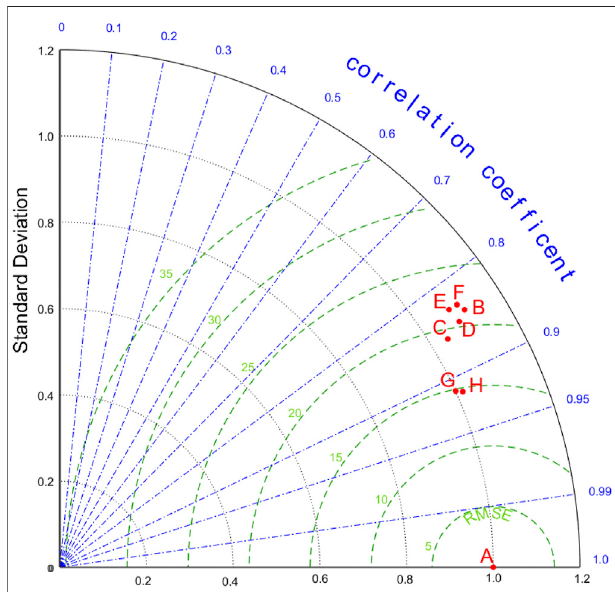
FIGURE 8 | Taylor diagram of the fi ve CMIP5 models, BMA, and grid- based BMA ensemble (A represents observation, and B to H represent